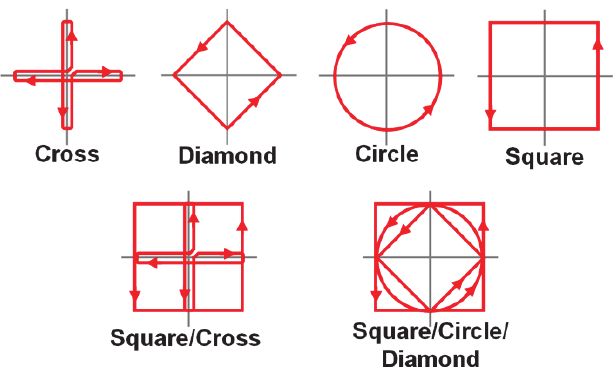
Figure 5: Applied periodic  x ×  xy /  3 strain paths on six tension-torsion tubular specimens, all of them with normal and effective shear amplitudes 0.6% .